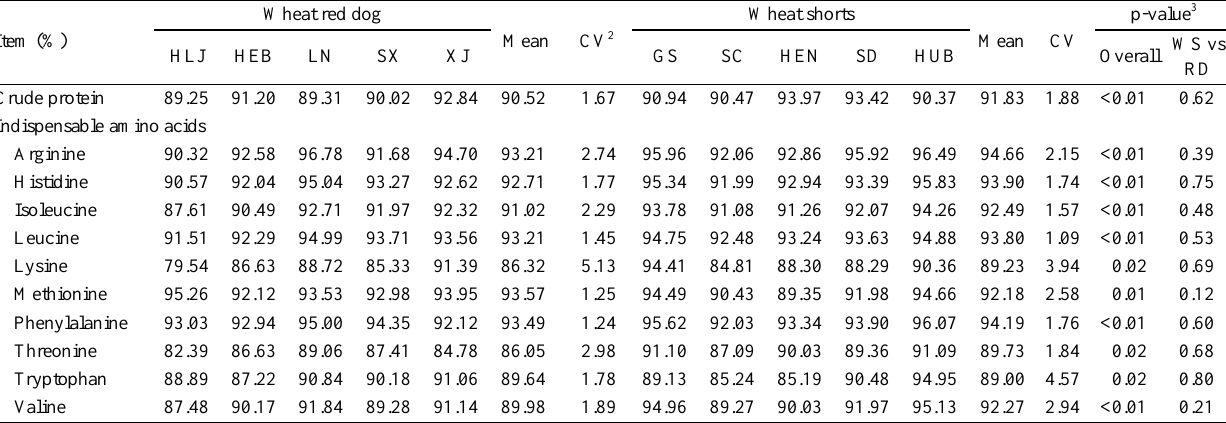
Table 10. Standardized ileal digestibility (%) of crude protein and amino acids in wheat shorts and red dog tested in Exp. 2 (% as fed) 1